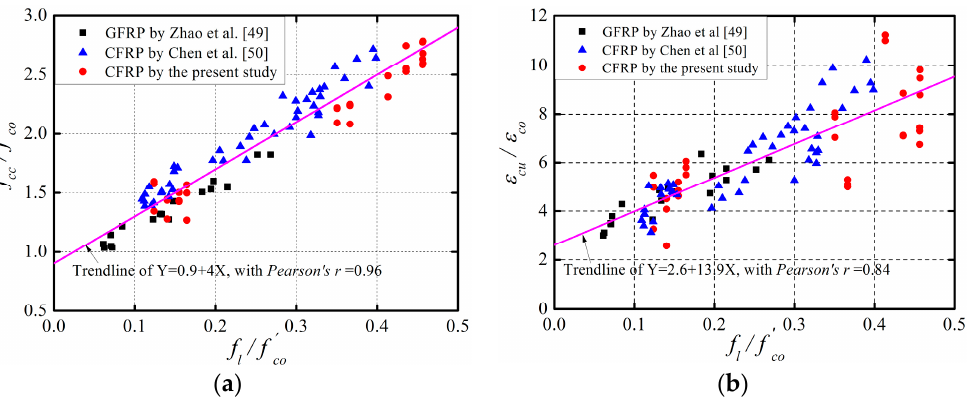
Figure 6. Effects of confinement ratio on FRP-confined RAC. ( a ) Strength gain ratio vs. confinement ratio; ( b ) Strain gain ratio vs. confinement ratio.